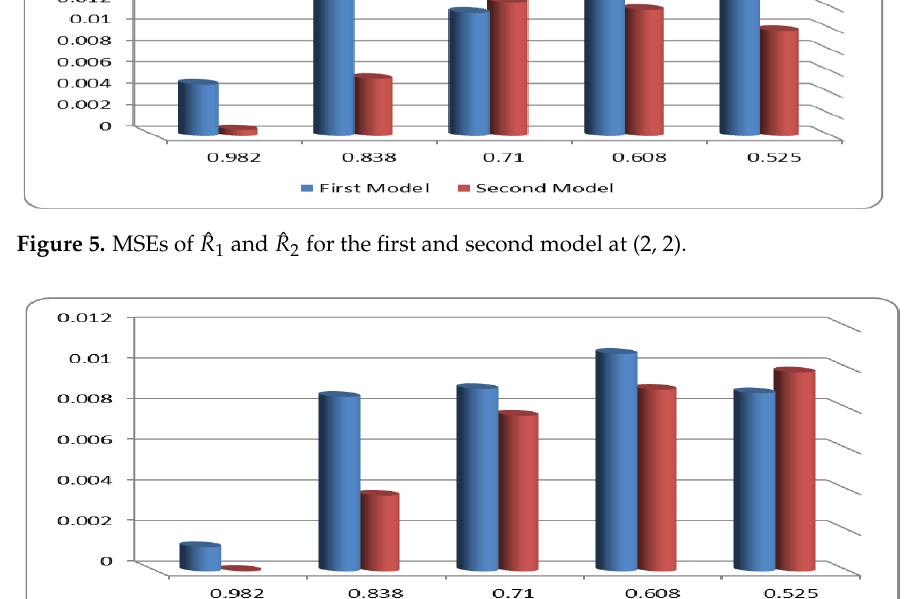
Figure 6. MSEs of